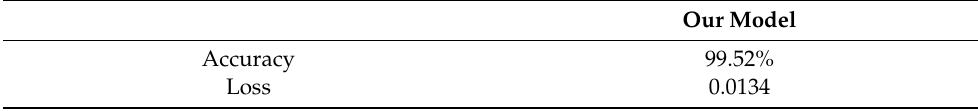
Table 2. Accuracy and loss from training model.